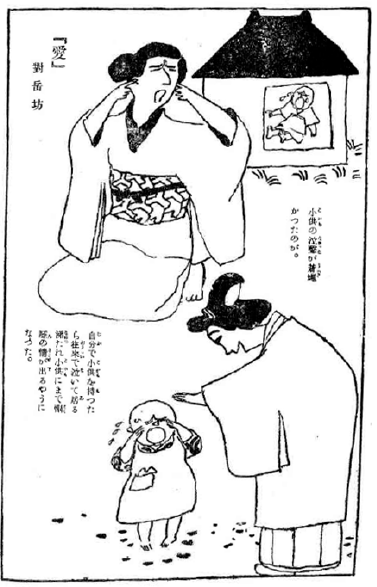
Figure 3. The manga